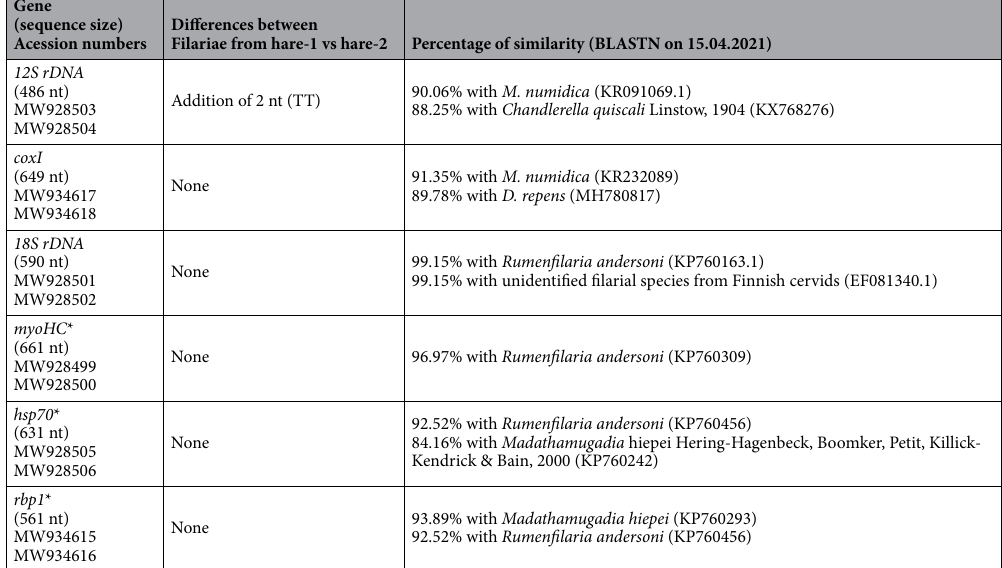
Gene (sequence size) Differences between Acession numbers Filariae from hare-1 vs hare-2 Percentage of similarity (BLASTN on 15.04.2021) 12S rDNA (486